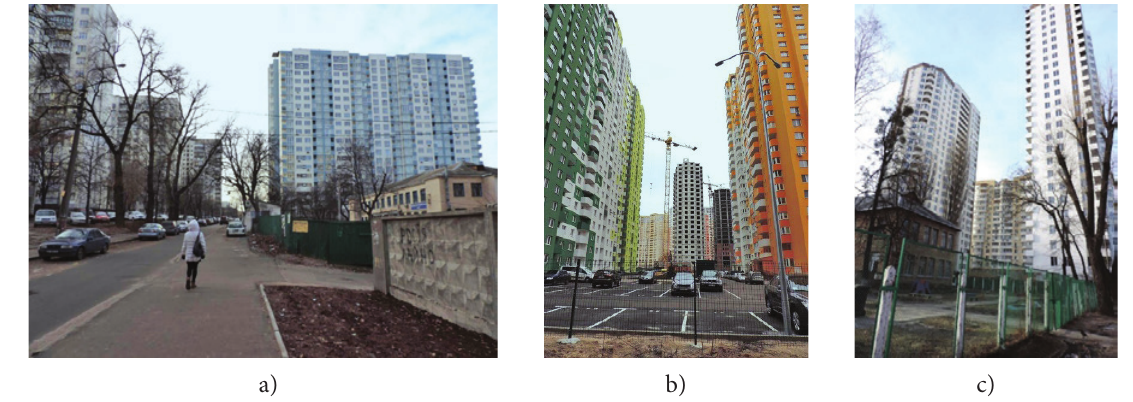
Figure 1. Multistorey residential buildings in Kyiv based on a simple description of a rhythm (source: author, 2017); a, c) Buildings in the residential district of Solomenskiy. The number of floors is 20–30; b) Buildings in the residential area between Vasylkivska and Teremky districts. The façade consists of monotonous windows and bay windows which are repetitive in form, it creates an aggressive visual environment in the